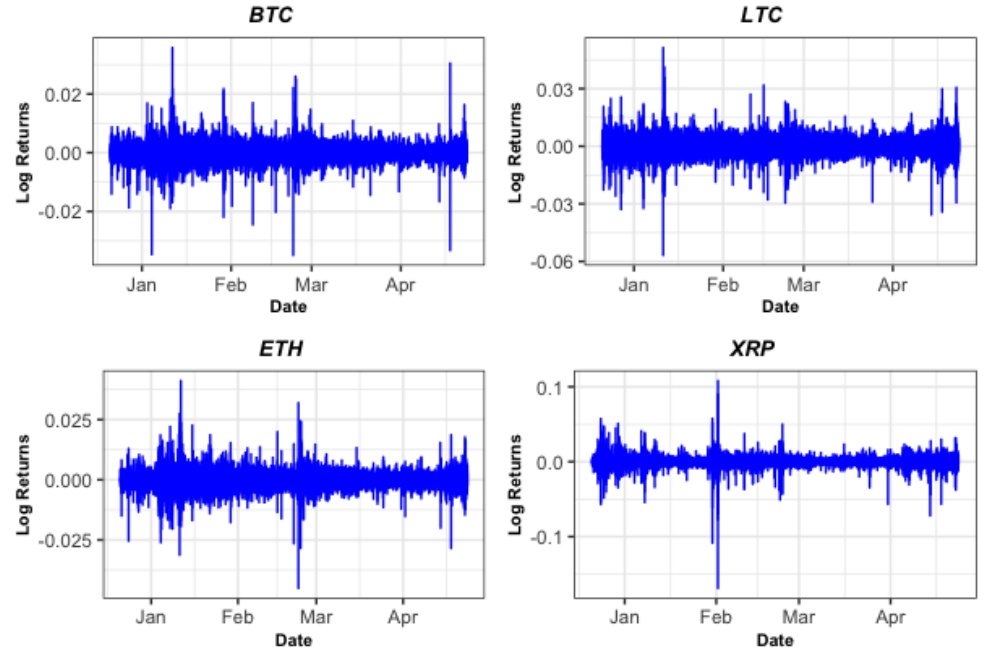
Figure 2. One-minute log returns ( r t ) of all coins. Note: Data observation time period: 21